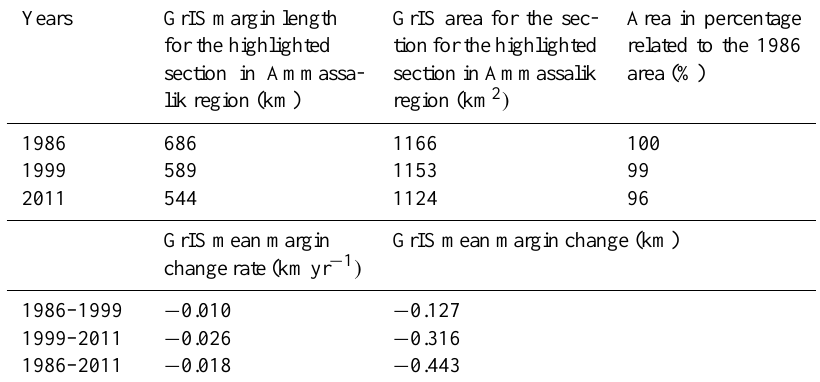
Area in percentage related to the 1986 area (%)